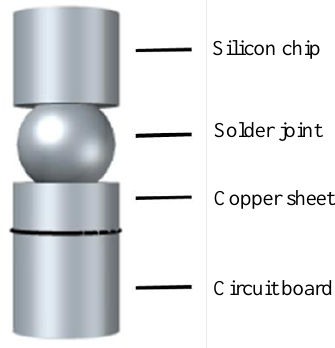
Figure 2. Schematic of the flip chip component assembly material.